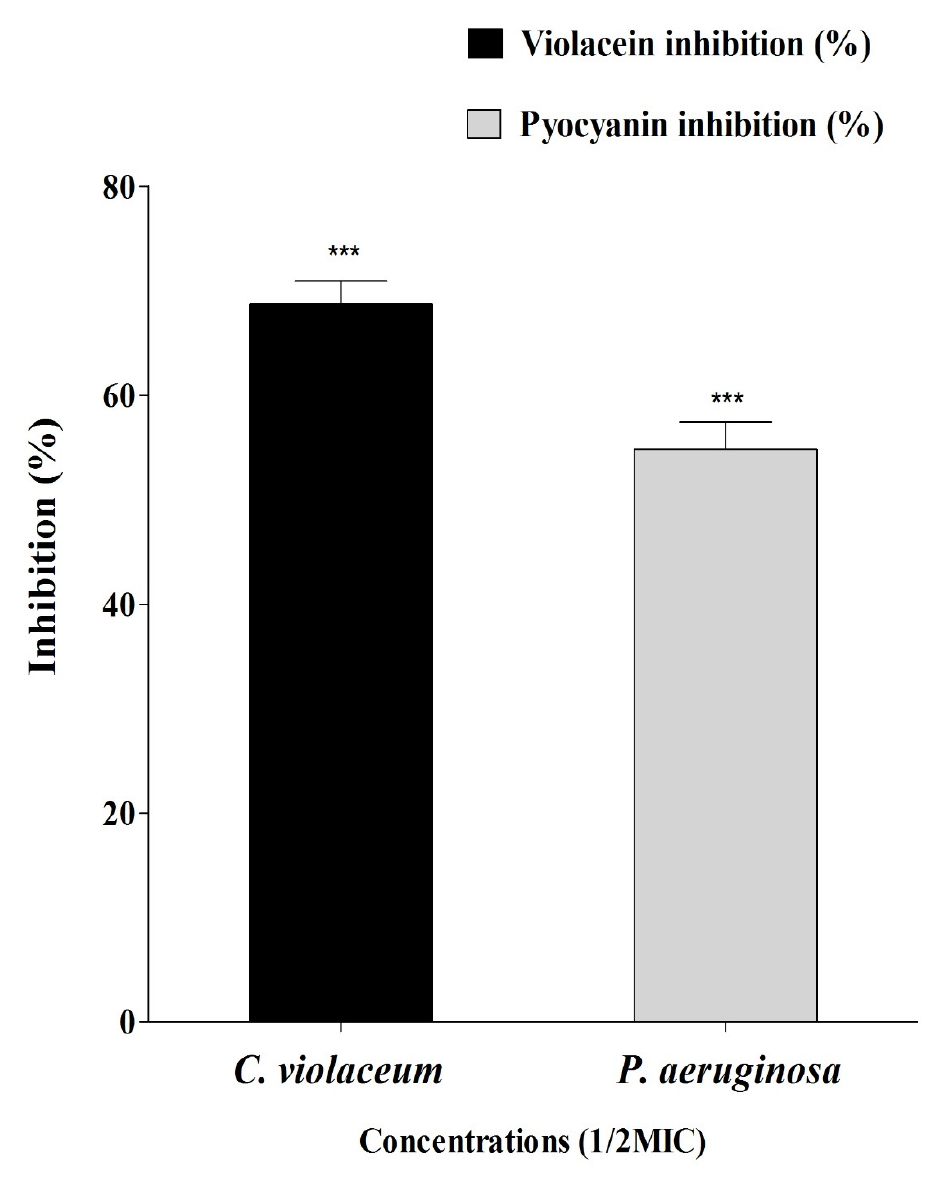
Figure 2. Anti-quorum sensing properties of Sumra honey against two bacterial strains. Error bars indicate SDs ( ± standard deviation) of three independent experiments. Bars with *** indicates statistically significant ( p < 0.0001) compared to control.